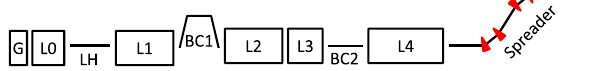
FIG. 1. Sketch, not to scale, of the FERMI linac-plus-spreader FEL-2 beam line. This study applies from the exit of L0 to the spreader end. Only the first magnetic bunch compressor, BC1, is active and for these calculations is presumed to give perfect linear compression.